Question: Express in one sentence what the figure is showing.
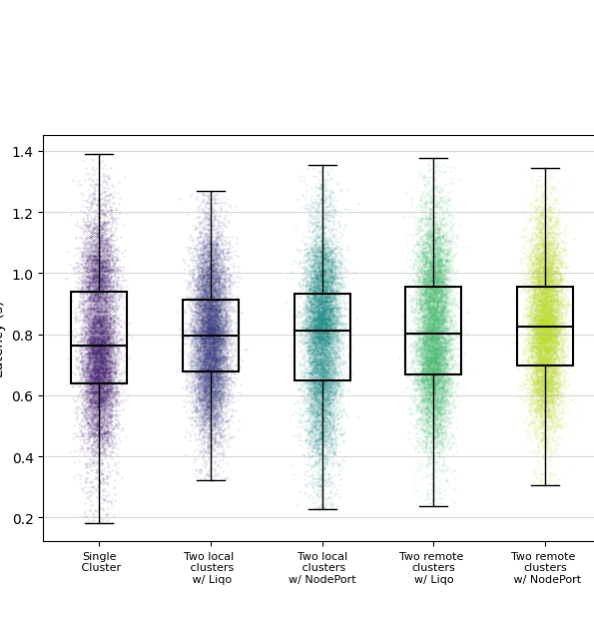
Answer: Latency between streaming and view times for each scenario.